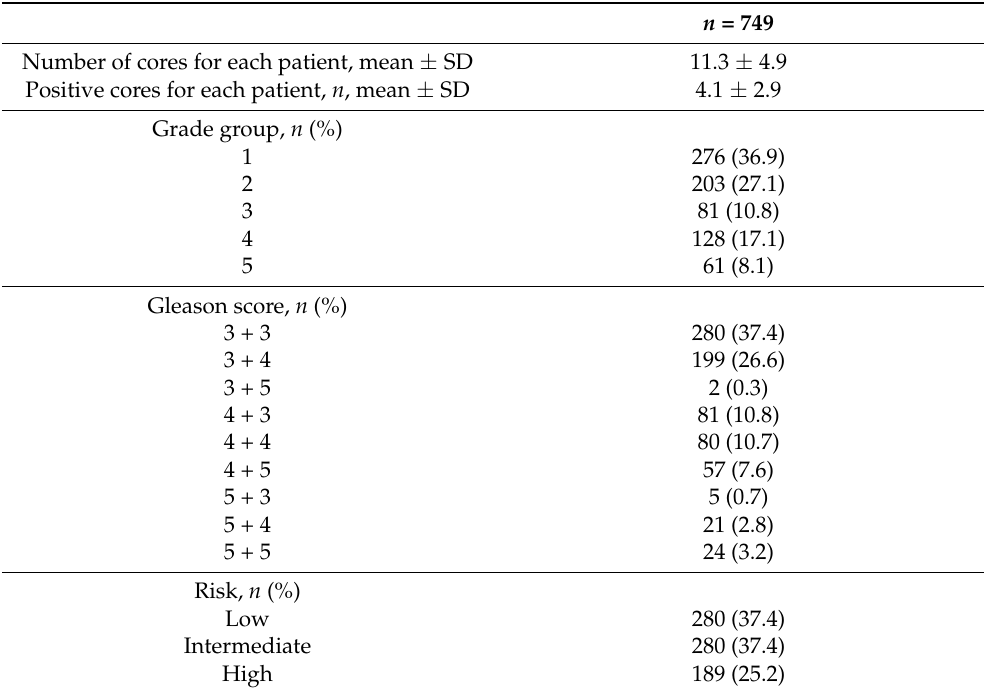
Table 2. Characteristics of the cores with neoplasia ( n =